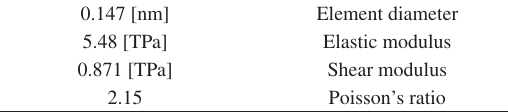
Figure 4. The vacancy defect in CNT structure. Table 1. Mechanical and geometrical properties of elements.